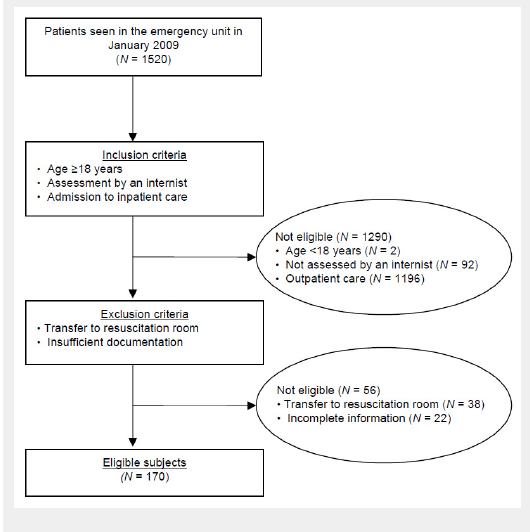
Identification and construction of the study cohort. In the study cohort, we included all adult patients (age ≥18 years) admitted from the emergency unit to the medical wards of the University Hospital Zurich between January 1st and January 31st, 2009. Patients managed primarily by an anaesthesiologist in the resuscitation room, and those with missing diagnostic information were